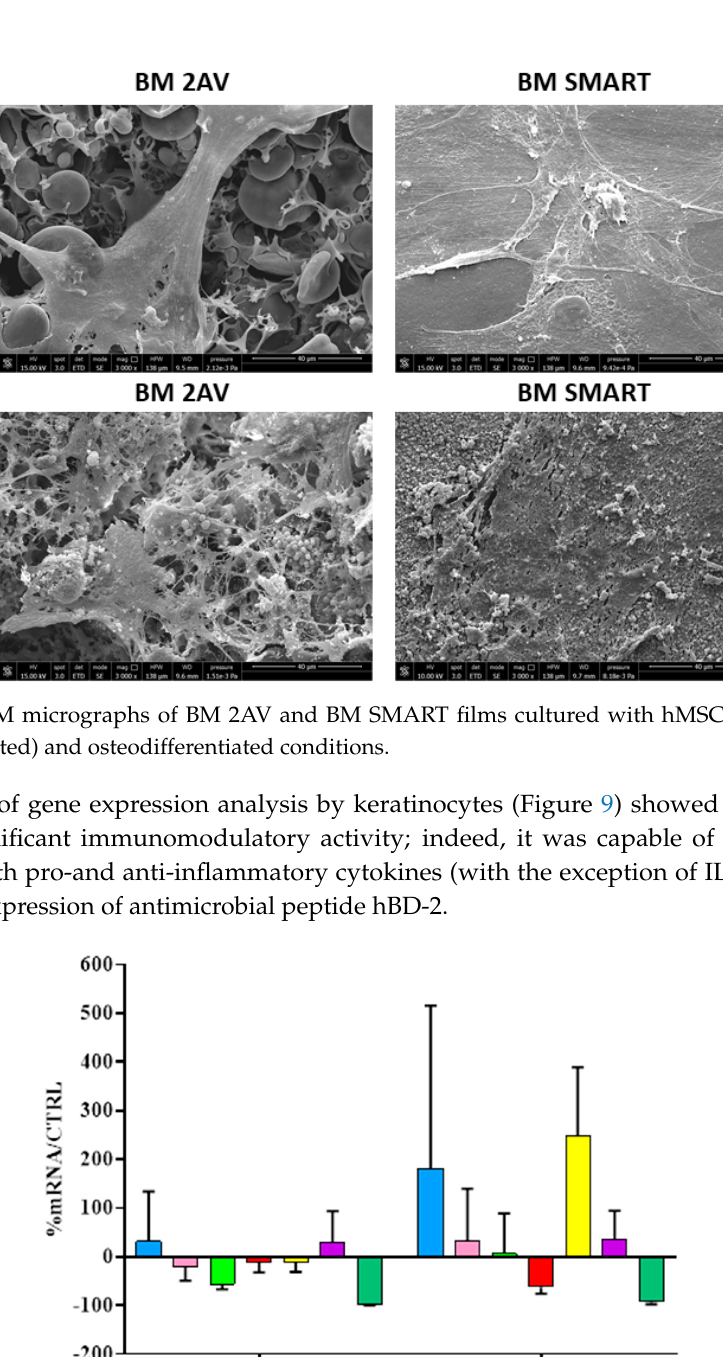
Figure 7. HMSC metabolic activity after being in contact with films of BM 2AV and BM SMART for 4 (blue) and 8 (brown) days.